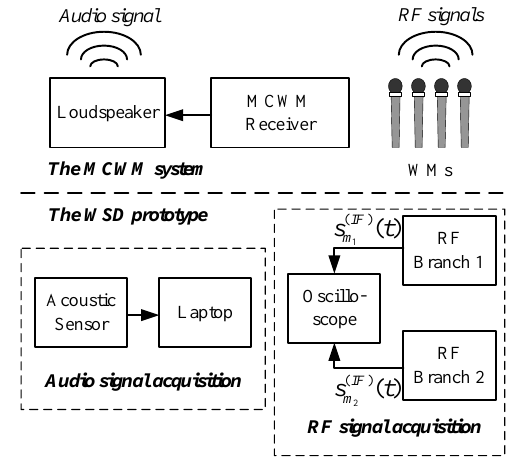
Figure 9. Block diagram of the real-world testing environment.